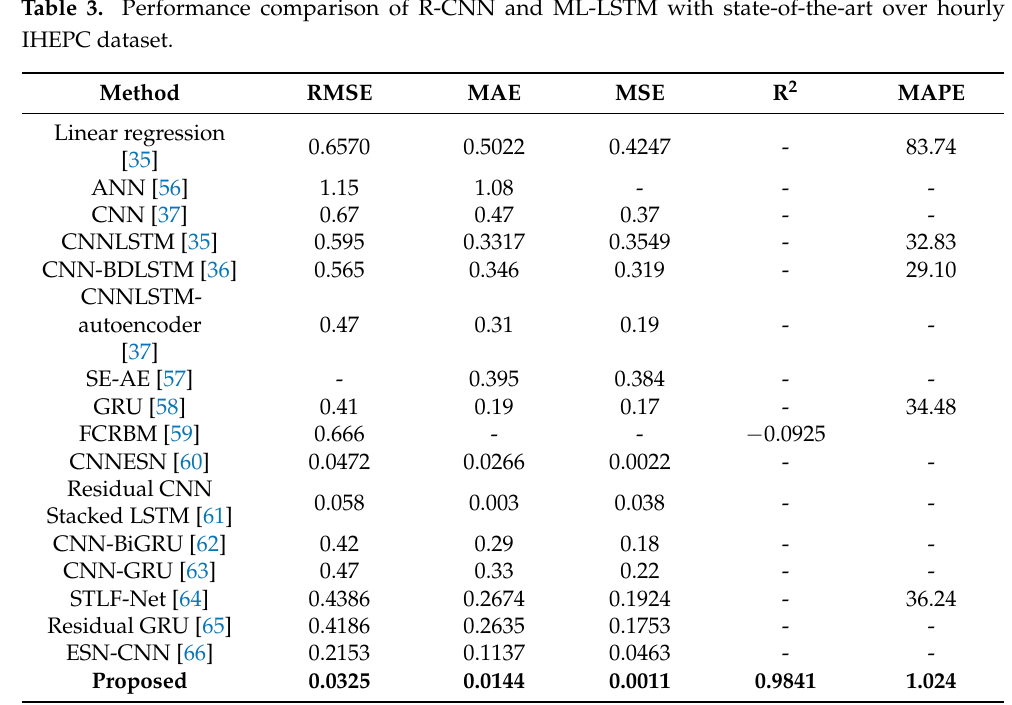
Table 5. Performance comparison of the proposed model with state-of-the-art forecasting methods over the PJM hourly dataset.